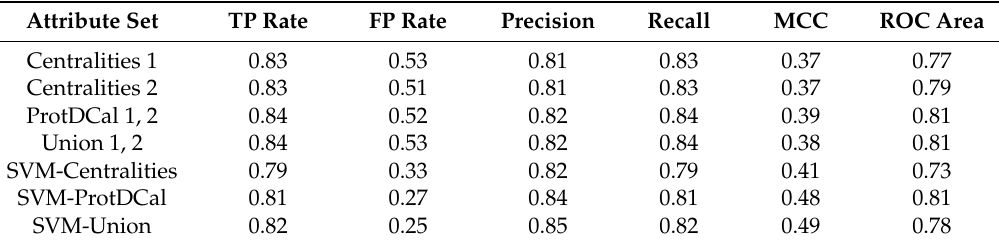
Table 2. Leave-One-Out Test for JAMMING1SET.